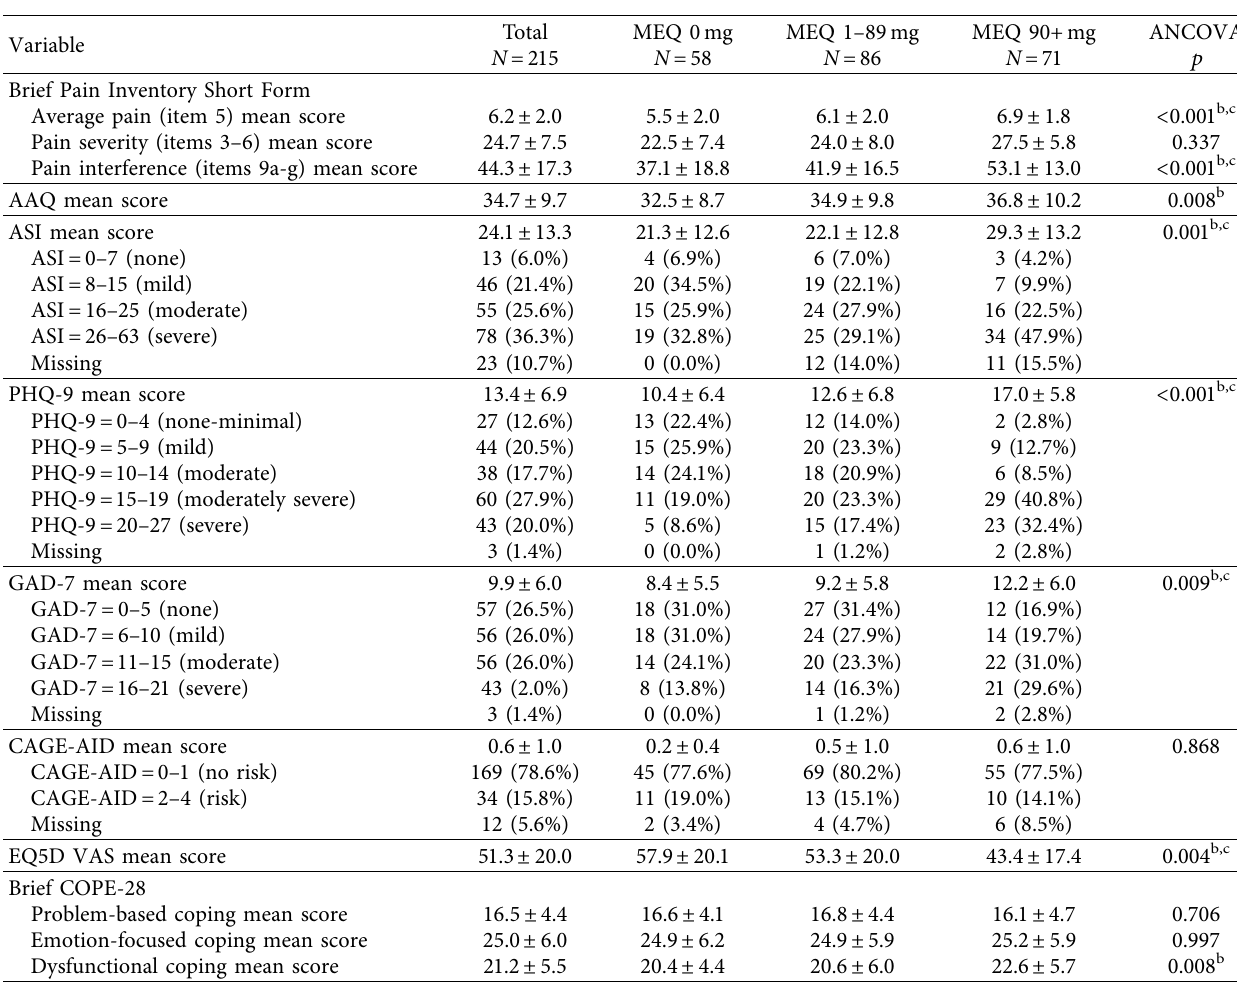
Table 3: Outcome